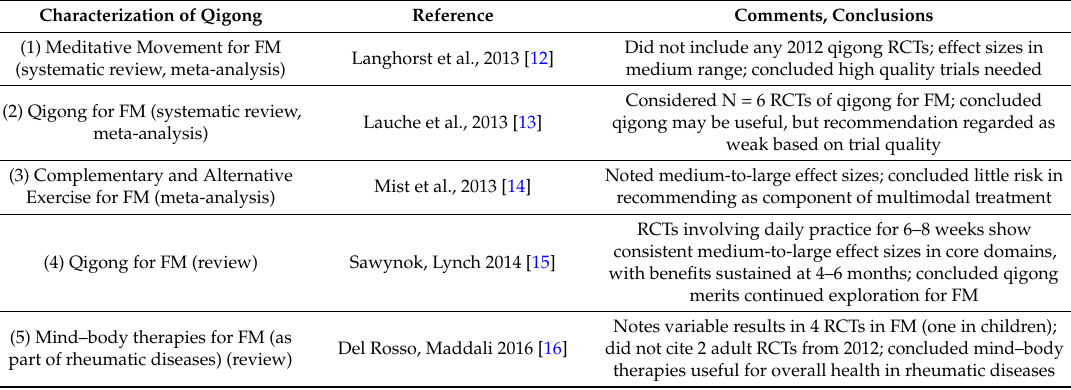
Table 1. Characterization of qigong within recent reviews and overviews of treatments for fibromyalgia